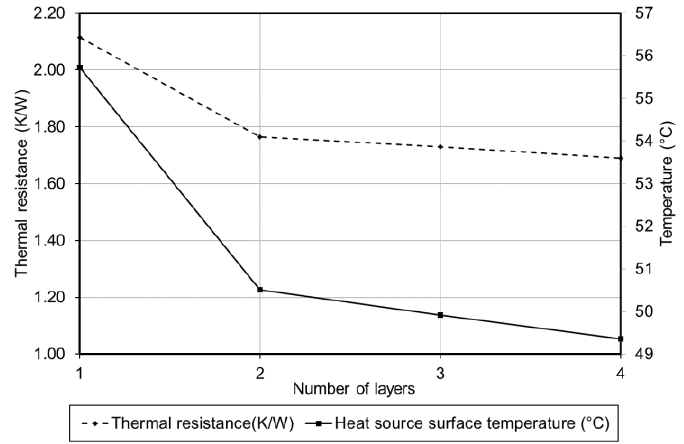
Figure 8. Effects of number of layers on the thermal resistance and heat source temperature of 30 mL/min HTF flow rate and 15 W power rate.